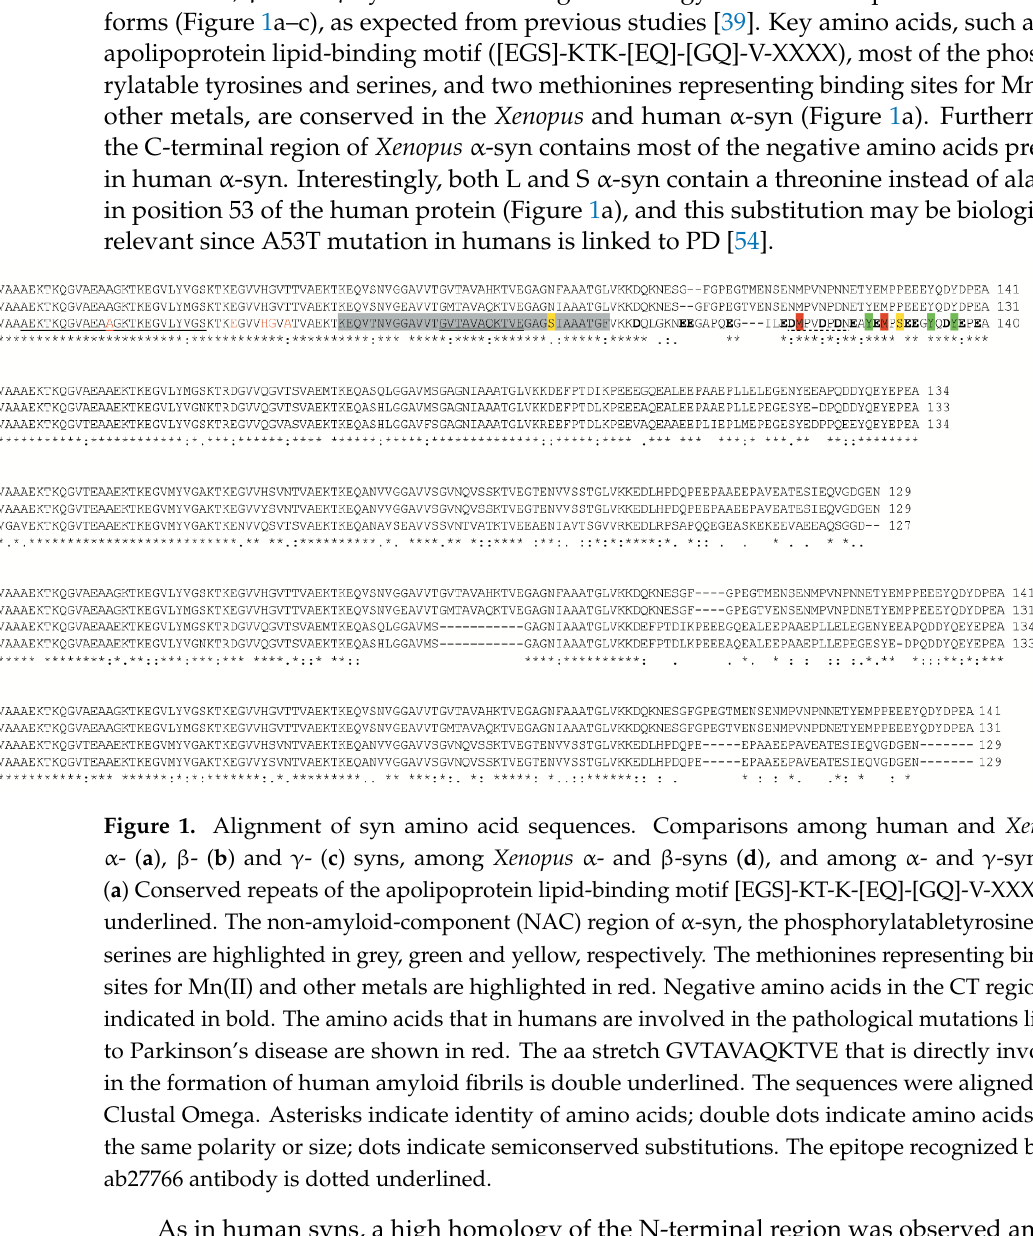
Table 1. mRNA coding sequences and amino acid sequence comparison between L and S syns. * indicates partial sequence.